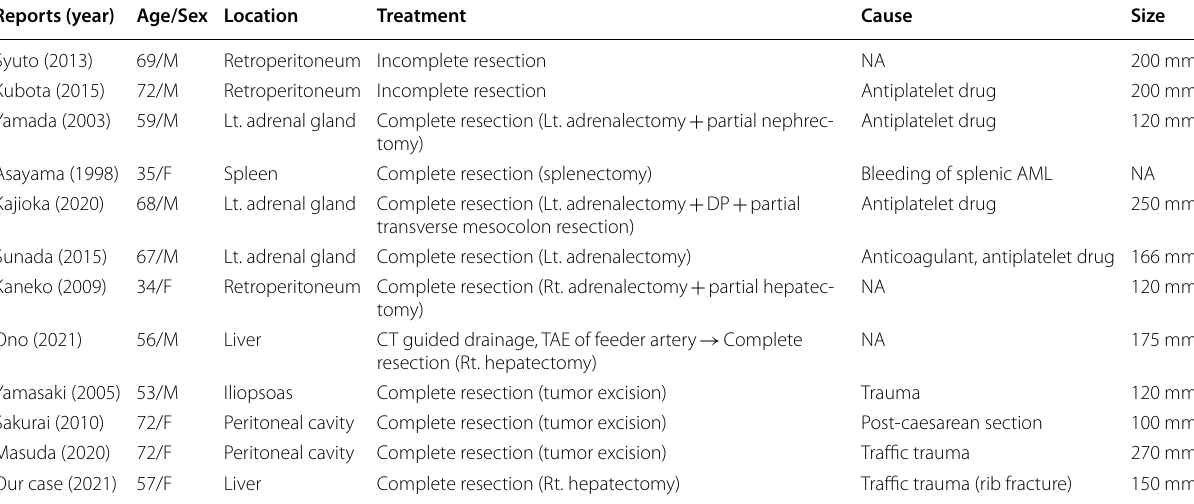
DP distal pancreatectomy, TAE transcatheter arterial embolization, NA not available, AML